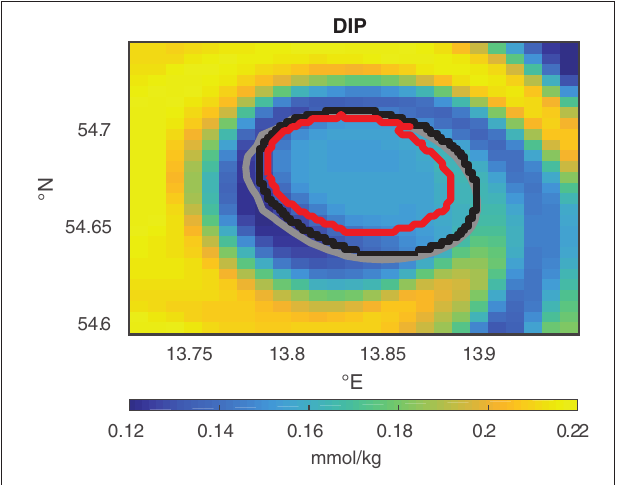
FIGURE 3 | Comparison of the eddy shapes of M V (gray), TOA (black), and the TA area fraction that stays 80% of the actual age of an eddy together (red) for eddy E2 at April 11, 2010 09:00 a.m. The color-coded map shows the dissolved inorganic phosphorus (DIP) concentration inside and around the eddy at this instant of time, with low concentration inside the eddy shapes and higher concentrations around the eddy.